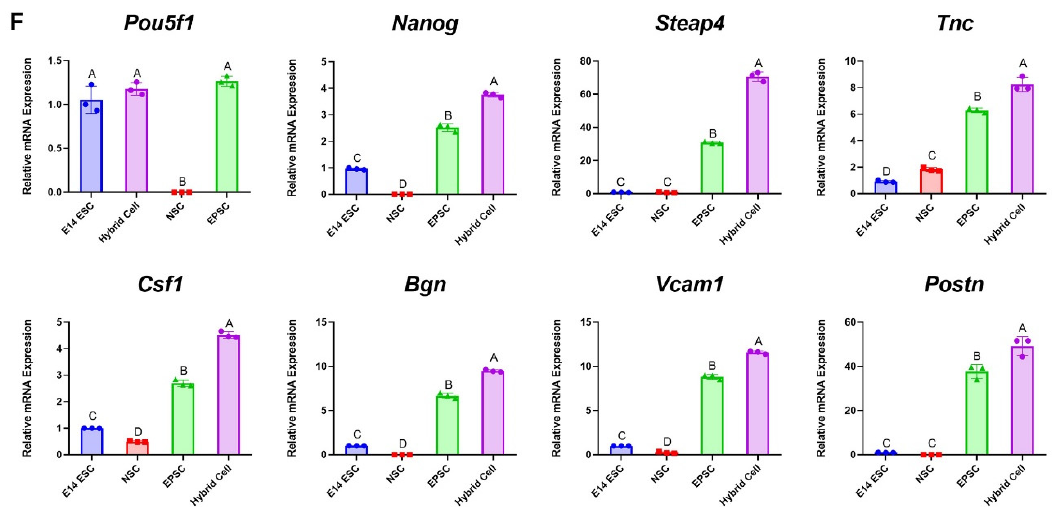
Figure 2. Reprogramming of NSCs by cell fusion with EPSCs and characteristics of the fusion hybrid cells. ( A ) Schematic illustration of cell-fusion-mediated reprogramming of NSCs with EPSCs. ( B ) Bright-field image (left) and fluorescence image (right) of Oc4-GFP + established EPSC-NSC hybrid cells. Scale bars: 200 µm. ( C ) X-gal staining assay of EPSC-NSC hybrid cells. Scale bars: 200 µm. ( D ) Karyotype analysis showed the near-tetraploidy of EPSC-NSC hybrid cells. Scale bars: 50 µm. ( E ) Immunocytochemistry images of EPSC-NSC hybrid cells for pluripotency markers, OCT4 and NANOG (red). Nuclei were counterstained by DAPI (blue). Scale bars: 200 µm. ( F ) quantitative RT- PCR analysis of EPSC-NSC hybrid cells about EPSC-specific upregulated genes. Data are presented as the mean ± SD for n = 3 independent experiments and every dot indicates the expression value of each sample. Gapdh was used as a housekeeping gene. EPSC-NSC hybrid cells expressed similar level of Oct4, Nanog, Tnc, Bgn, Vcam1, and Postn to EPSCs. Hybrid cells expressed higher levels of Steap4 and Csf1 than EPSCs. EPSCs and EPSC-NSC hybrid cells showed a higher level of EPSC markers, Steap4, Tnc, Csf1, Bgn, Vcam1, and Postn. A–D Uppercase indicates significant differences